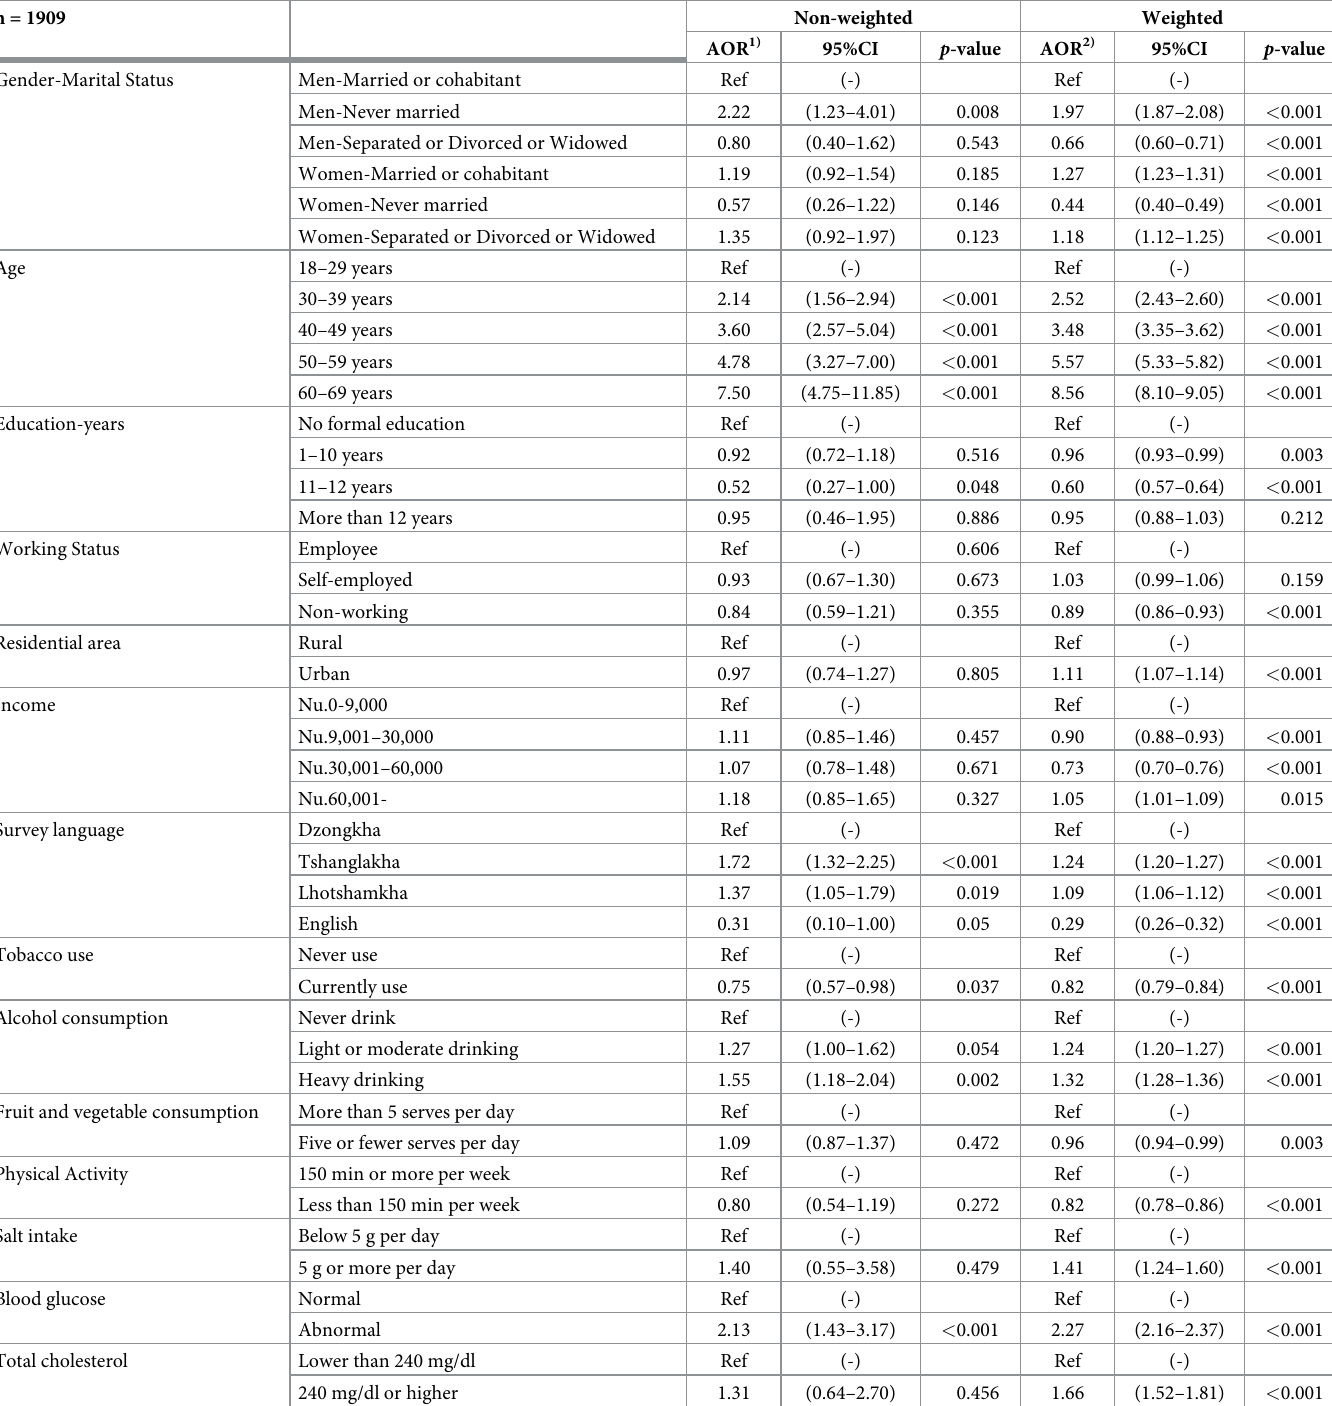
Table 3. Multivariable logistic regression analysis for hypertension with sociocultural, lifestyle, biomedical, and mental health variables (n = 1,909). n =